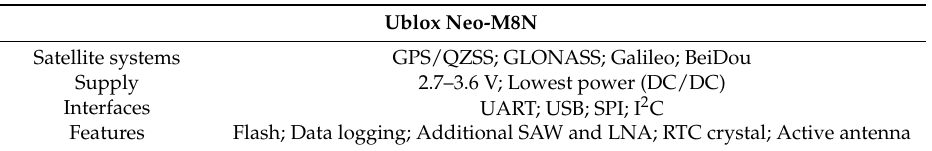
Table 1. Main technical characteristics for GNSS receiver “Ublox Neo-M8N”.